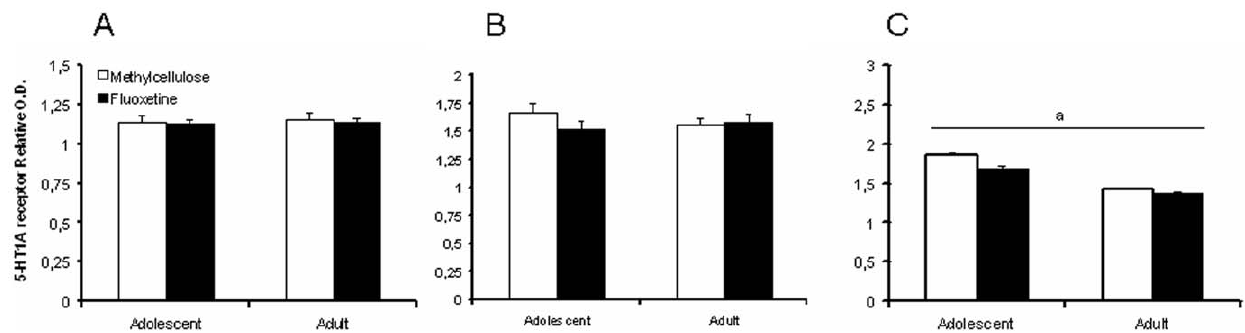
Figure 7. The relative optical density of 5-HT 1A receptor immunostaining in the dorsal raphe nucleus, mPFC, and amygdala of fluoxetine and methylcellulose treated adolescent and adult rats. Data are presented as mean 6 S.E.M. of O.D. in the dorsal raphe nucleus (A), mPFC (B), and amygdala (C) (n=4–5) per 100 6 100 m m. 14–17 Days following chronic fluoxetine (12 mg/kg) treatment no differences in 5-HT 1A immunostaining were found in the dorsal raphe nucleus, mPFC and amygdala. Yet, 5-HT 1A receptor immunoreactivity was lower in adult compared to adolescent rats in the amygdala. a p , 0.05 main age effect. doi:10.1371/journal.pone.0016646.g007 PLoS ONE |